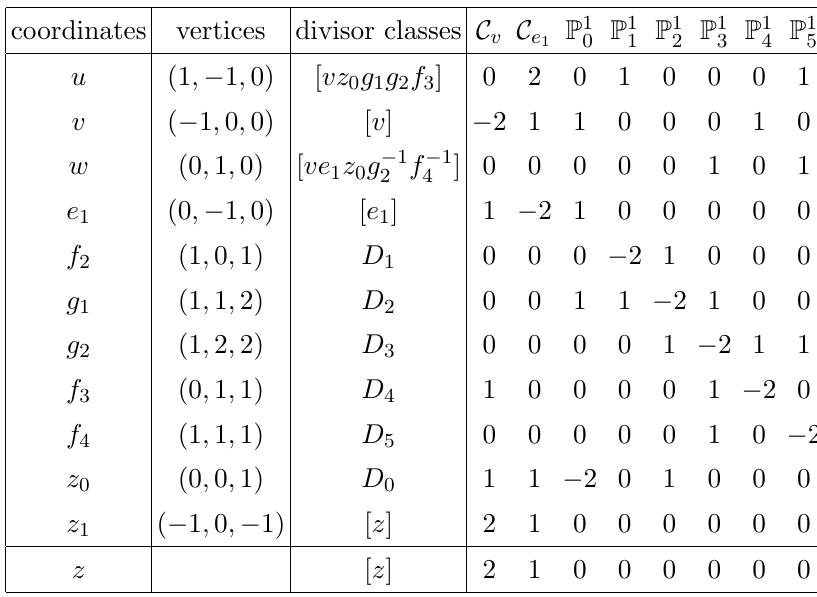
Table 4 . Coordinates, vertices, divisor classes and intersection numbers (charges of C (cid:3) -actions) for the three-dimensional toric variety dP 1 with SO(10) top, (cid:12)bered over P 1 . The divisor [ z ] is given by [ z 0 f 2 g 2 g 2 f 3 f 4 1 2